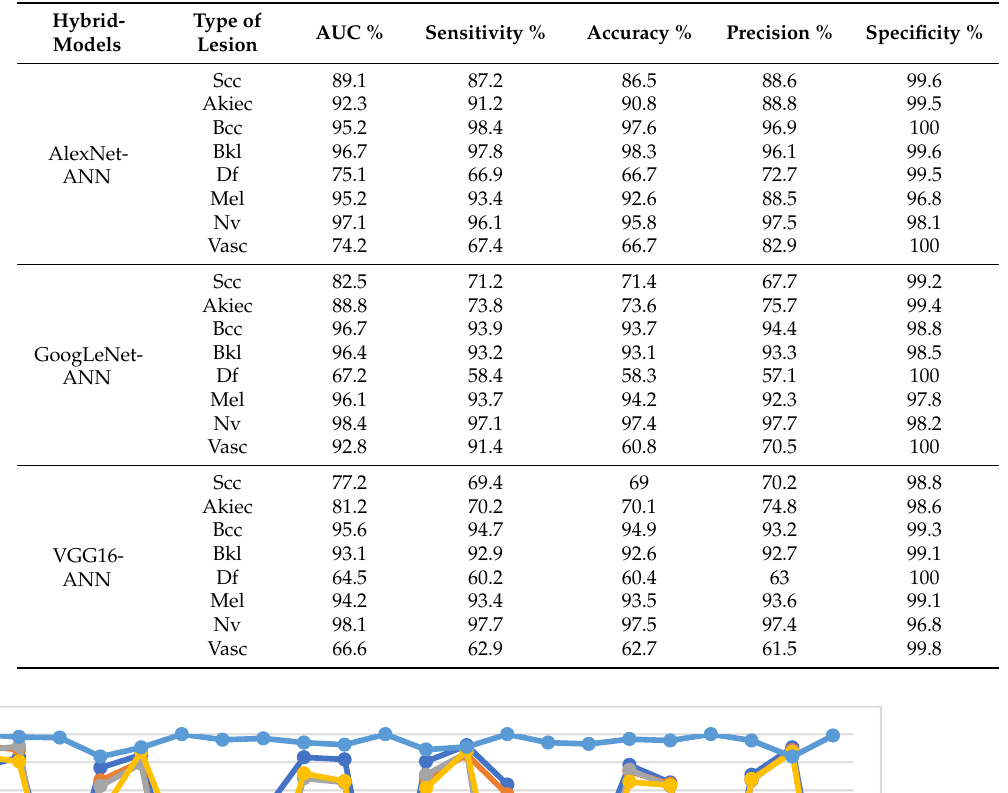
Table 5. Performance results of CNN-ANN hybrid models based on ROI using the GAC method for early diagnosis and differentiation of skin cancer and other skin lesions.